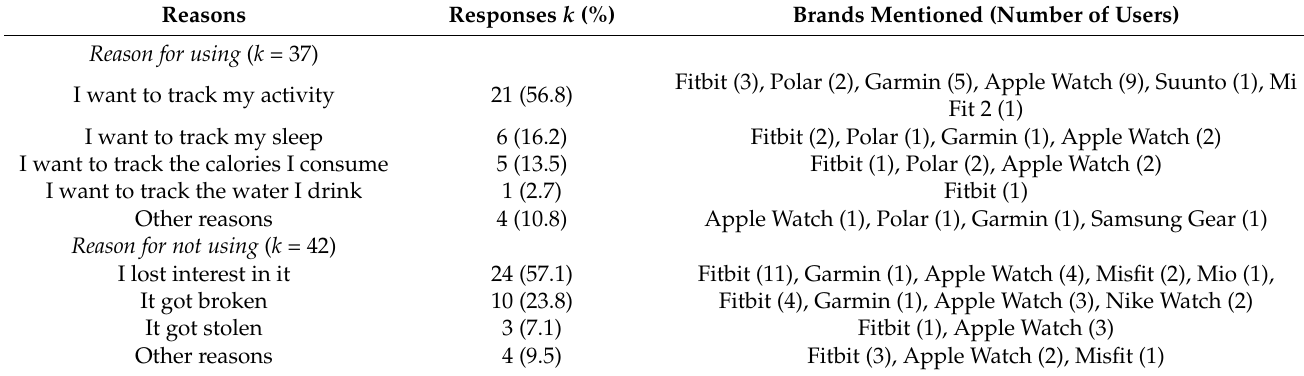
Table 3. Reasons for using and not using wearable